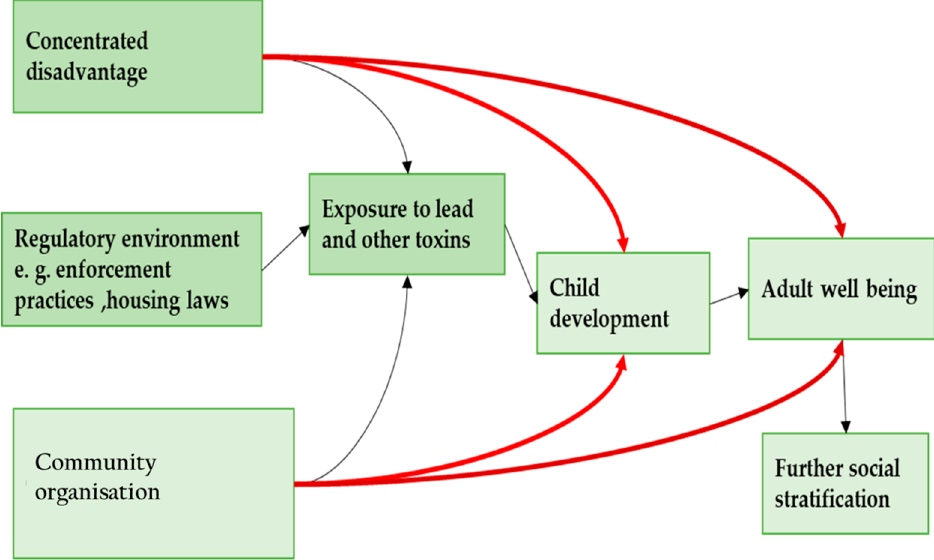
Figure 5. A model of inequality, environmental toxicity and well-being over the life course.